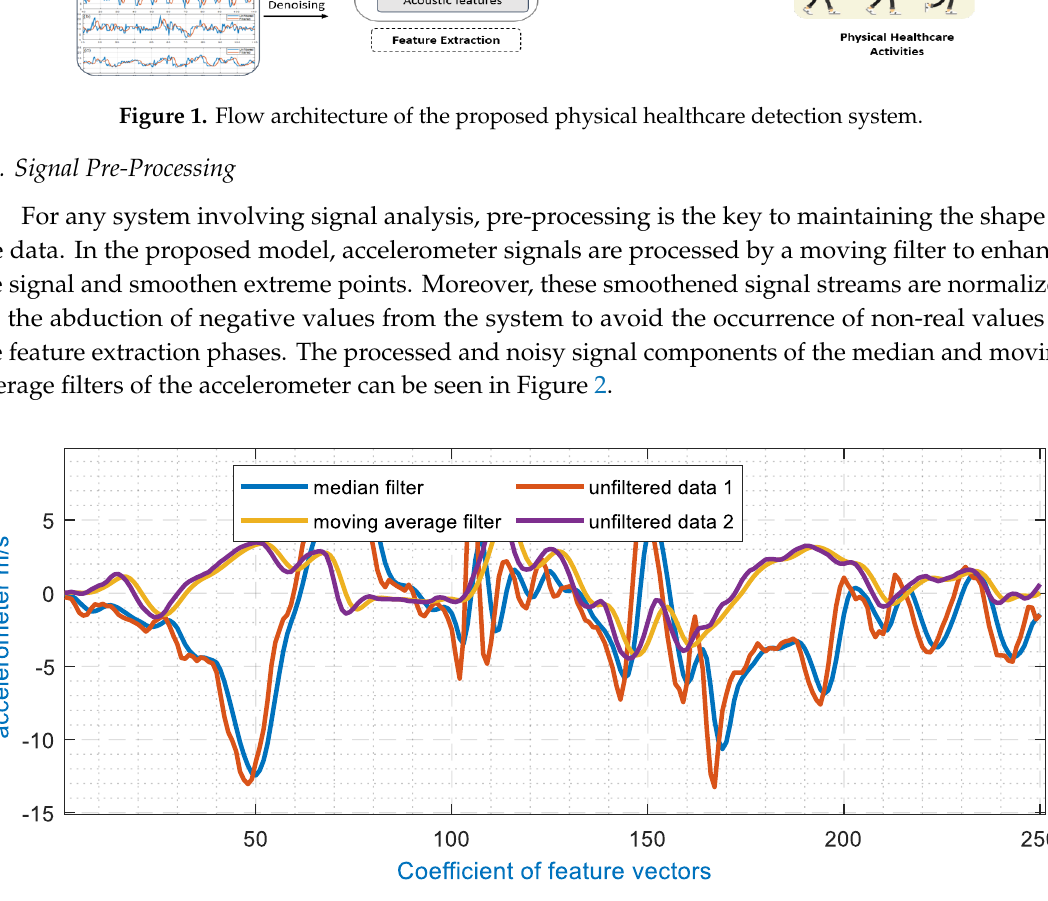
Figure 2. Signal preprocessing for wearable accelerometers in the proposed healthcare model.